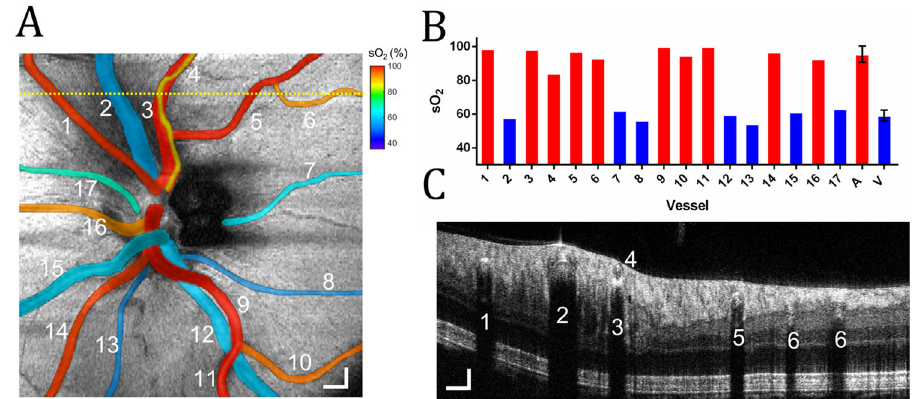
Fig. 4 Oximetry map of the optic disk. A sO 2 measurements in 17 vessels in the optic disk from a healthy 23-year-old. The sO 2 values pseudo-colored and overlaid onto the fundus image. Scale bar: 300 μ m; B Bar chart plots sO 2 measurements from panel A in individual arteries (red bar) and veins (blue) numbered from 1 to 17, as well as average sO 2 in all arteries and all veins; C B-scan from the position highlighted by the yellow dashed line in ( A .)